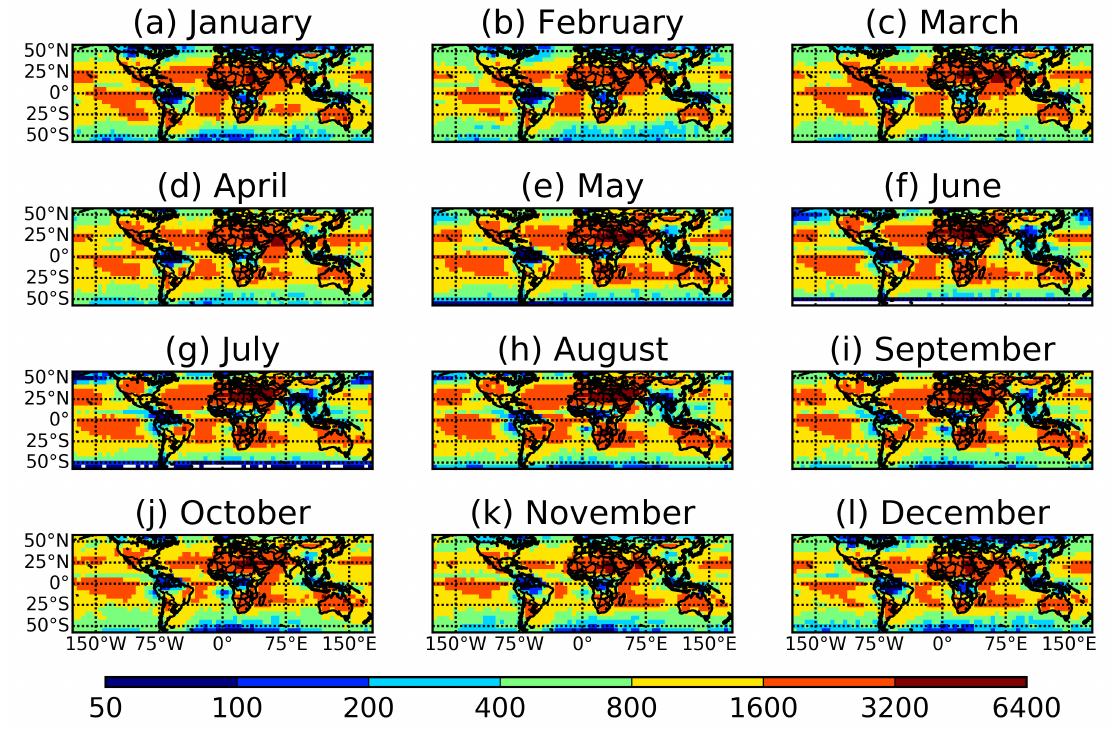
Figure A1. The number of AOD retrievals used to estimate monthly mean AOD in JOINT_AS product in each month. The values are averaged for the 17 years between March 2000 and February